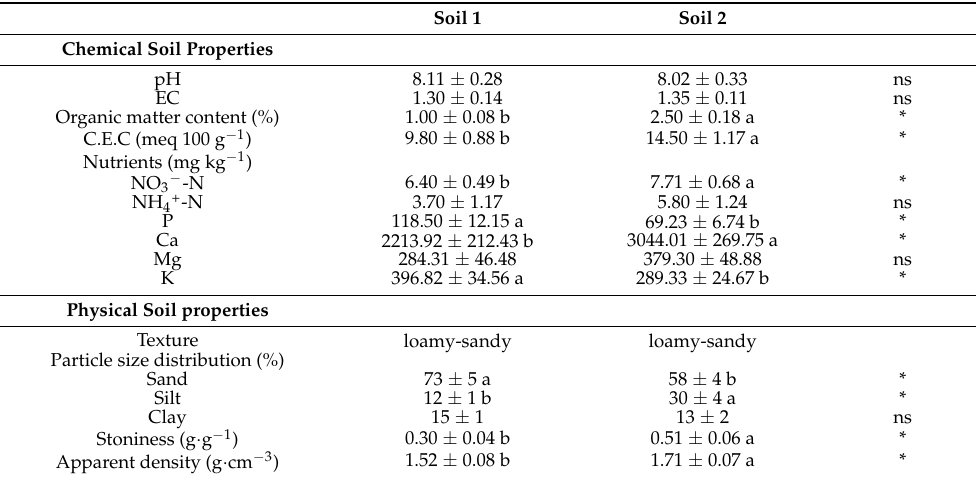
Table 1. Chemical and physical properties of the soil at the beginning of the experiment.